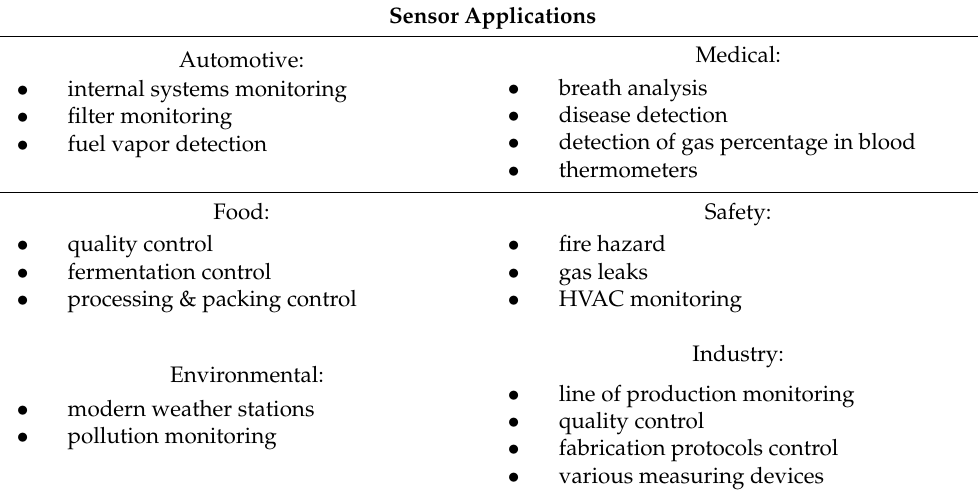
Table 1. Sensors applications in various domains, adapted from Ref.